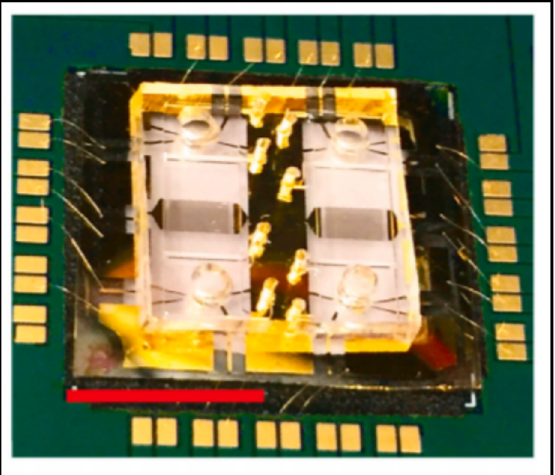
Figure 5. An ultra-high-frequency surface-acoustic-wave chip from Agostini et al. with the ability to multiplex up to four biomarkers. The red scale bar is 1 cm long. Reprinted with permission from [42]. Elsevier, 2021.